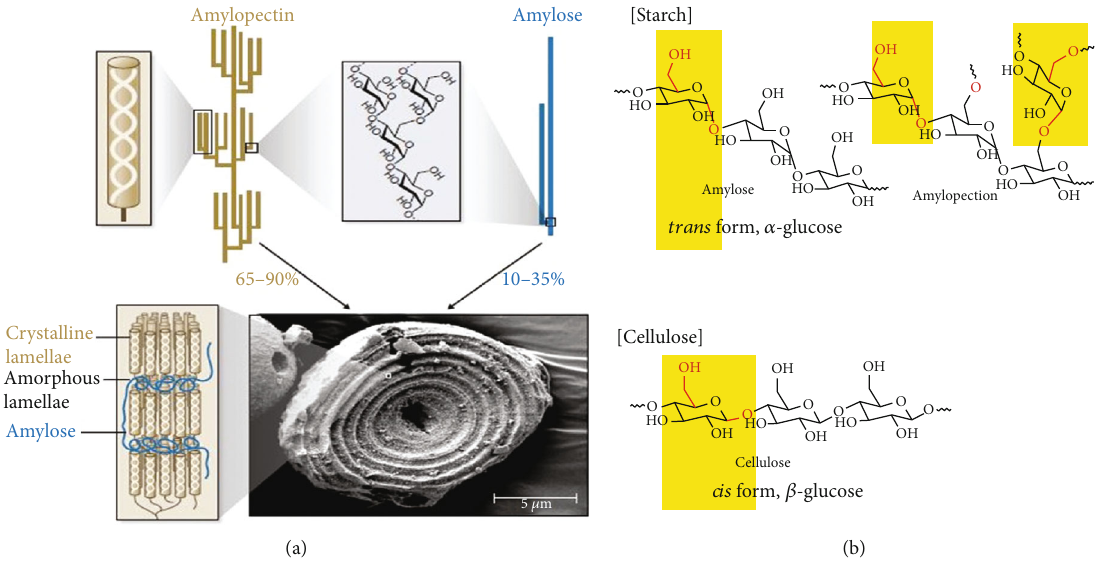
Figure 3: Structure of the starch granule (a) [8] and structural di ff erence of starch and cellulose (b).